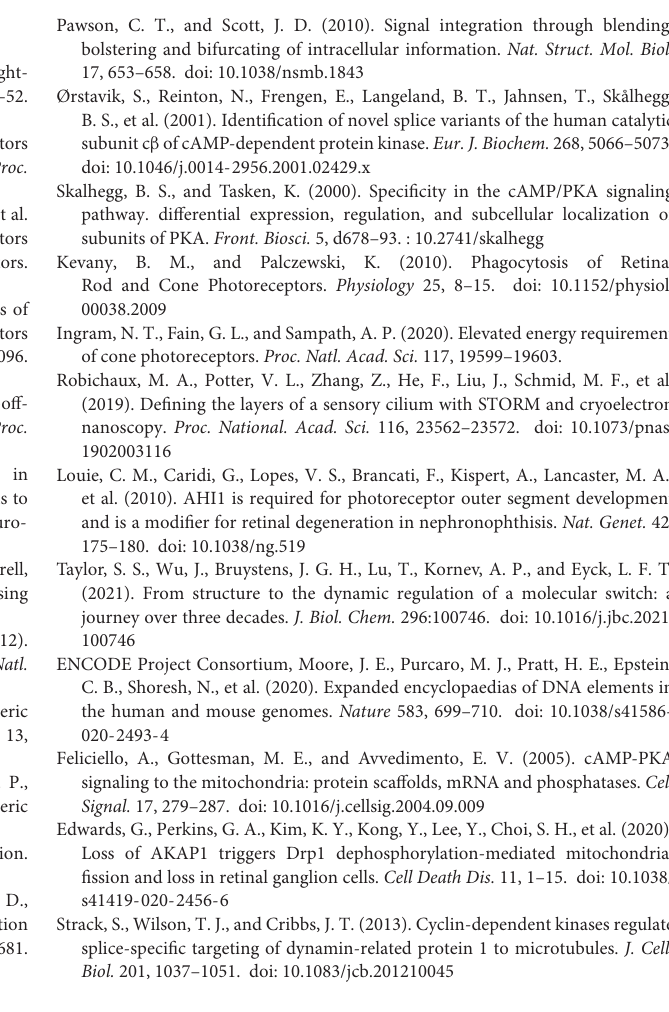
outer segment in images 1–3, in the mid region in images 4–6, and near the base (closer to the inner segment mitochondria ellipsoid) in images 7–9. Images 1–9 also confirm C α (green) is not present in the mitochondria ellipsoid (red). Blue line = z position (primary image), green line = top panel, red line = right panel. Green and red lines highlight localization in an individual cell, which can be further visualized in the top and right panel. Supplementary Figure 8 | RNA sequence alignments for C β 1, C β 3, C β 4, and C β 4ab. Differences at the N-terminus were sufficient to design BaseScope probes specific for each isoform (red section), with sequence similarities continuing beyond exon 1 (green section). Supplementary Figure 9 | BaseScope Duplex assay of C α , C β 1, C β 3, C β 4, and C β 4ab expression. All isoforms are expressed in photoreceptor and interneuron cells, with C β 4 and C β 4ab prominently expressed in all tissue layers. Color deconvolution was done following the technical note of ACD (TS 46-003/RevA/Date 6212018). The green color and red color were separated with Image J, darkened, and merged together using Adobe Photoshop. Supplementary Figure 10 | Antibody control for C α and C β . (A) Anti-C α antibodies specifically recognized purified C α protein and not purified C β 4 protein in Western blots, while anti-C β antibodies recognized purified C α protein and not purified C β 4 protein. Both C α and C β 4 were present at the predicted size of ∼ 39 kDa. (B) Human retina sections used as negative controls for corresponding IHC data showed no detectable signal after incubation with secondary donkey anti-rabbit and donkey anti-mouse